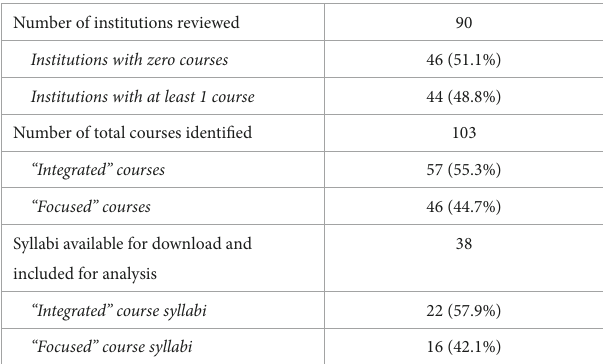
TABLE 1 Climate-health course